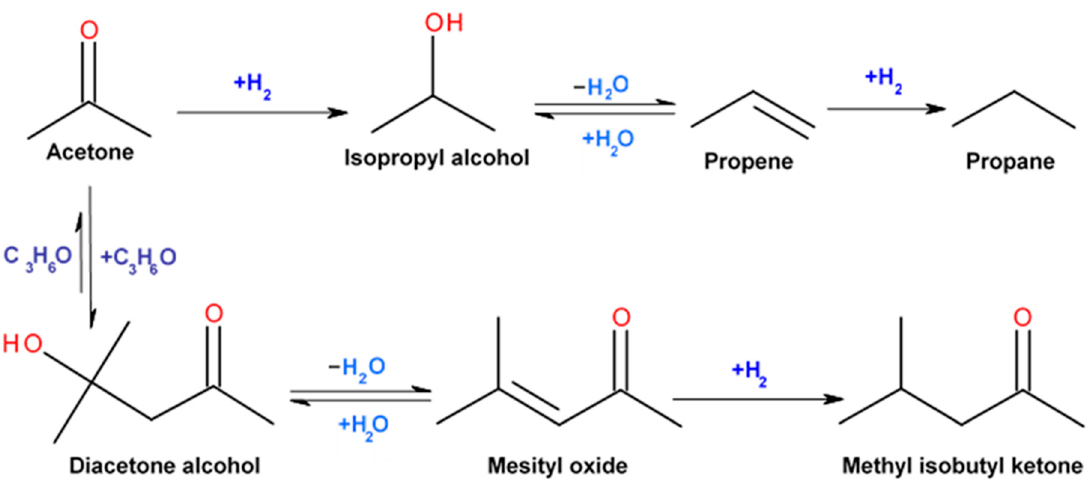
Figure 7. Reaction network scheme and possible pathways of acetone hydrogenation and condensation. The kinetics data were collected under internal and external diffusion-free